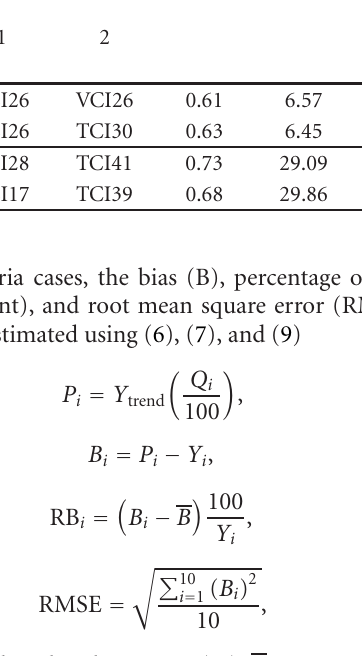
Table 2: Variables and statistical measures of the best models from Table 1. Divisions Model no. Regression coe ffi